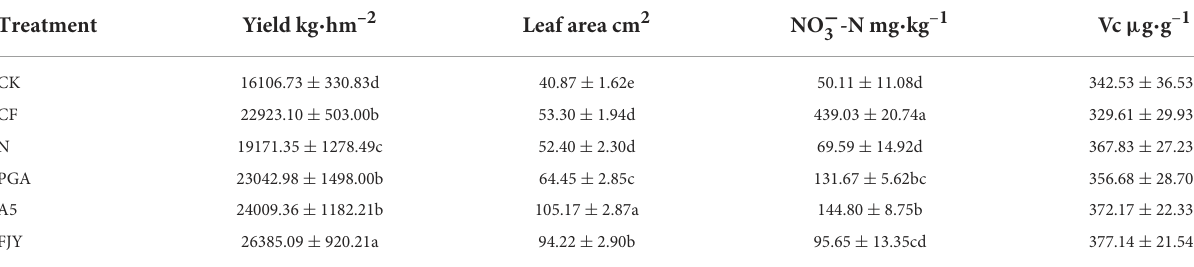
TABLE 1 Effects of different treatments on the yield and quality of Chinese